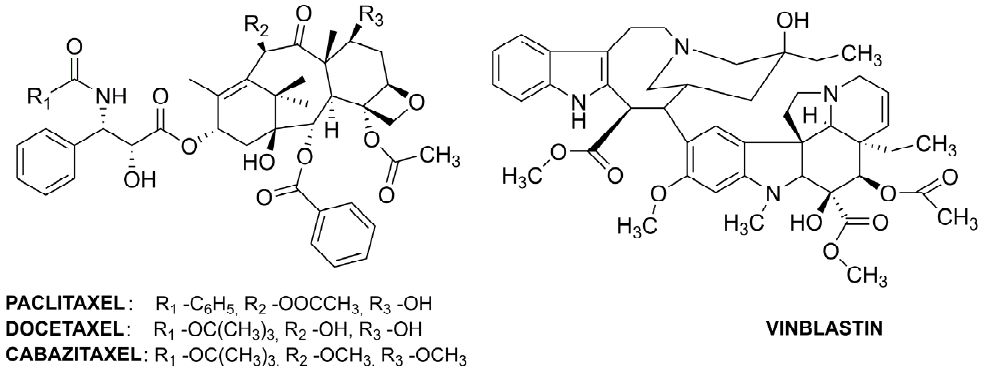
Figure 8. The selected structures of anticancer microtubule inhibitors.